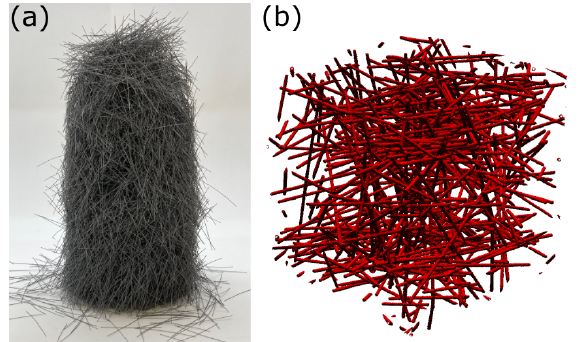
Figure 1. (a) Snapshot of a tower of fibres. (b) 3D reconstruction of a fibre assembly via X-ray